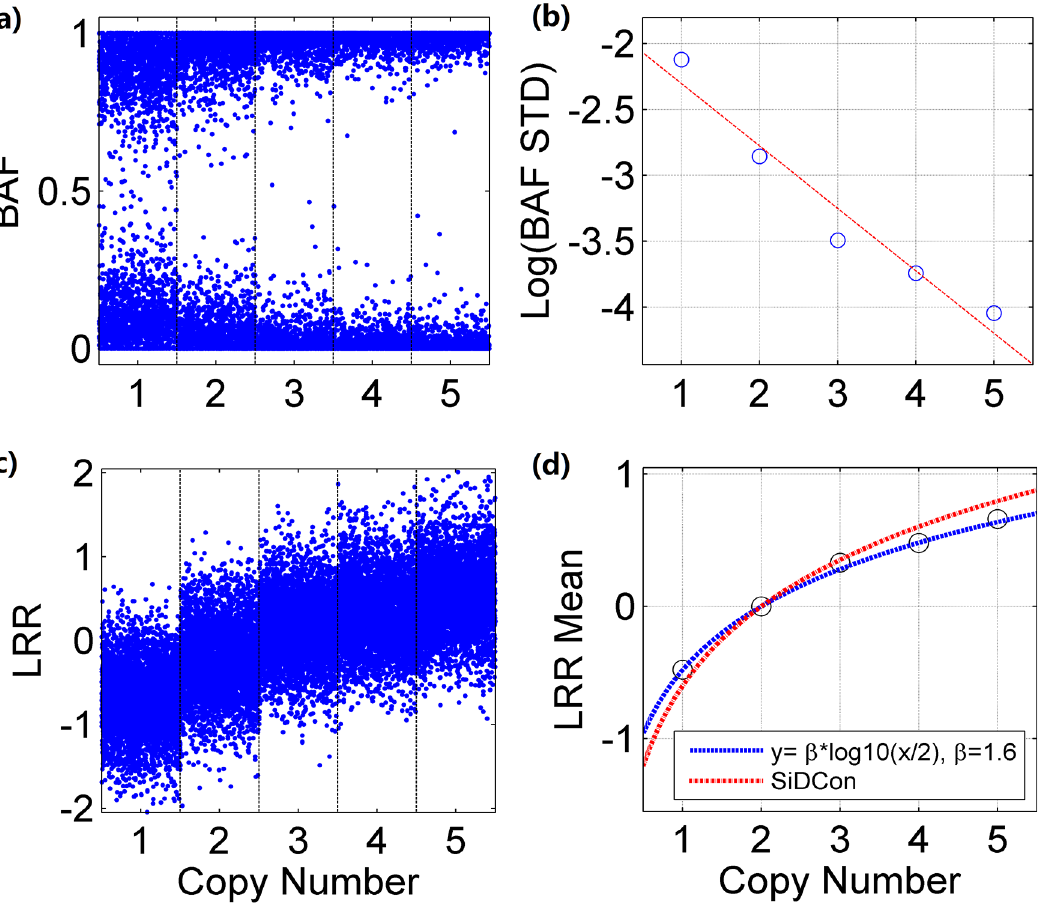
Fig 2. Comparison of LRR and BAF signals with respect to different copy numbers. The Log R Ratio (LRR) and B Allele Frequency (BAF) signals are illustrated with respect to different copy numbers. (a) Statistical distributions of BAF signals from homozygosity SNPs are shown with copy number from 1 to 5. (b) Comparison of BAF signal variances shows that the relationship of variance and copy number can be approximated by a log-linear function. (c) Statistical distributions of LRR signals are illustrated with copy number ranging from 1 to 5. (d) Comparison of real mean values of LRR and theoretical values calculated by two formulas for different copy